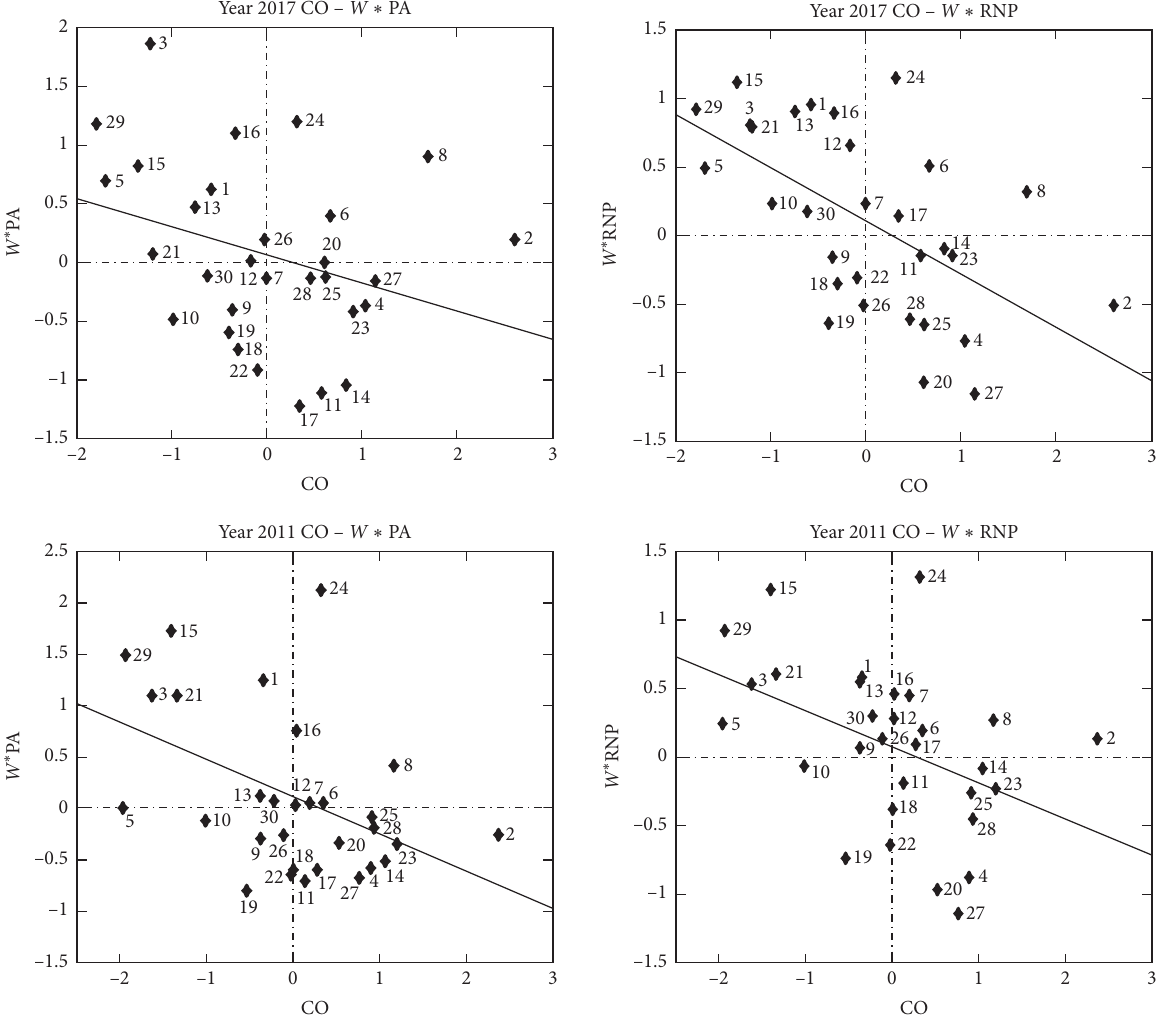
Figure 2: Bivariate global Moran scatterplot for 2017 and 2011 (the scatter numbers from 1 to 30 in the figure correspond to Anhui, Beijing, Fujian, Gansu, Guangdong, Guangxi, Guizhou, Hainan, Hebei, Henan, Heilongjiang, Hubei, Hunan, Jilin, Jiangsu, Jiangxi, Liaoning,